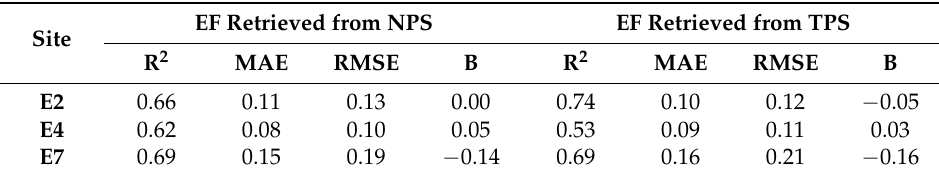
Table 6. Accuracy of EF retrieved from TPS and NPS within the dry edge determined by the TVX